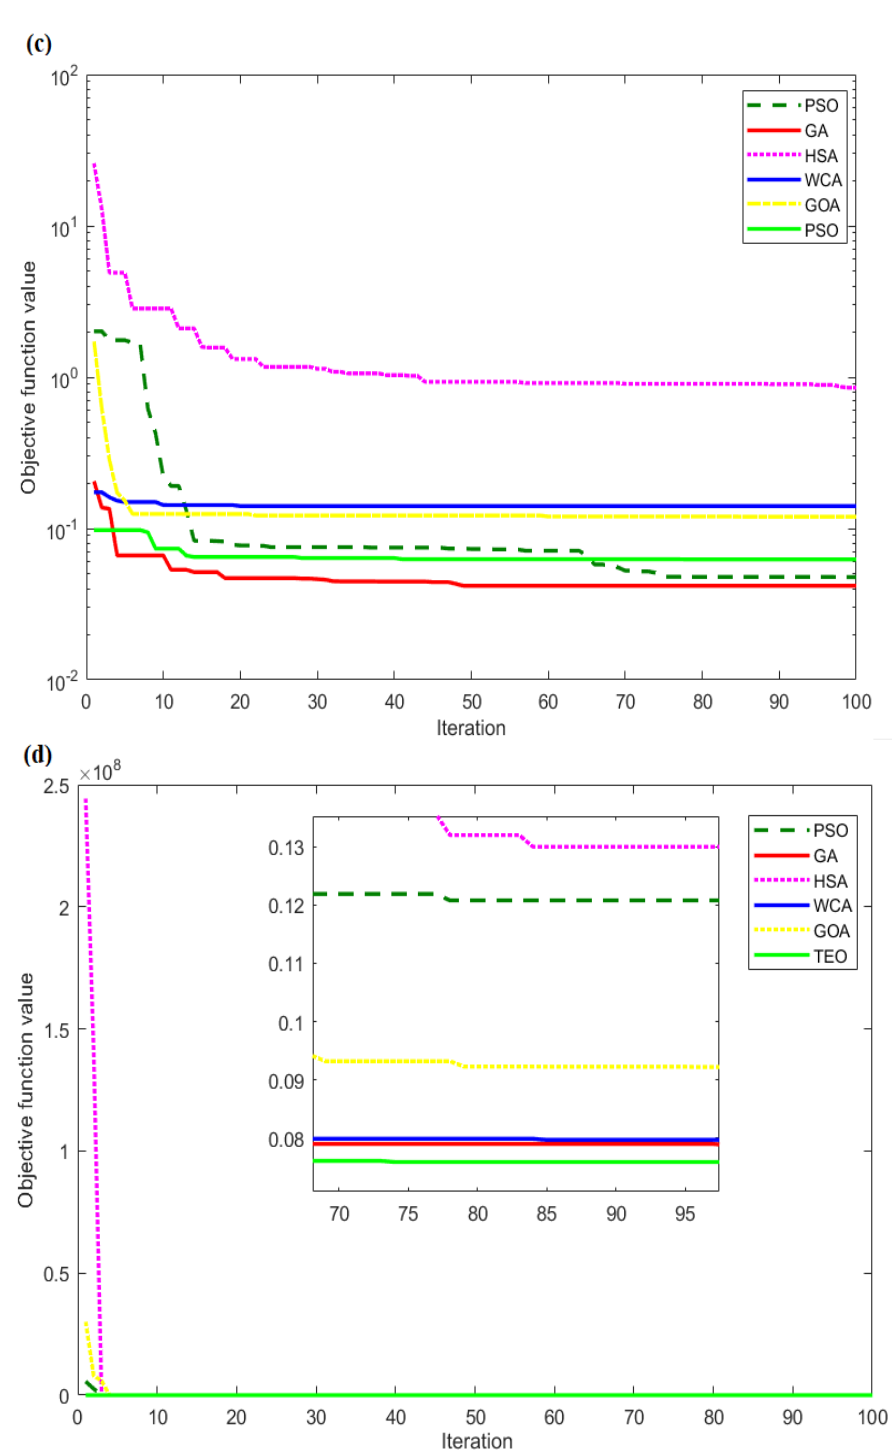
Figure 4. Convergence histories: ( a ) Integral Absolute Error (IAE); ( b ) Integral Square Error (ISE); ( c ) Integral Time-weighted Absolute Error (ITAE); ( d ) Integral Time-weighted Square Error (ITSE) index. Table 1. Optimization results of the problem (35).